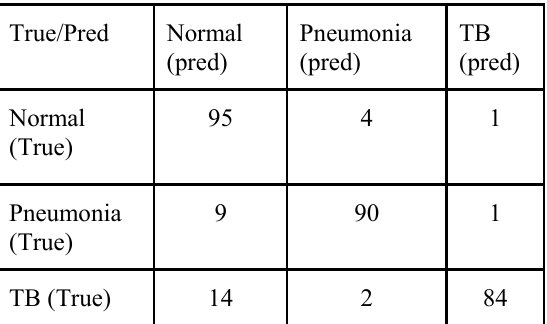
Table 3. Confusion matrix of model trained on